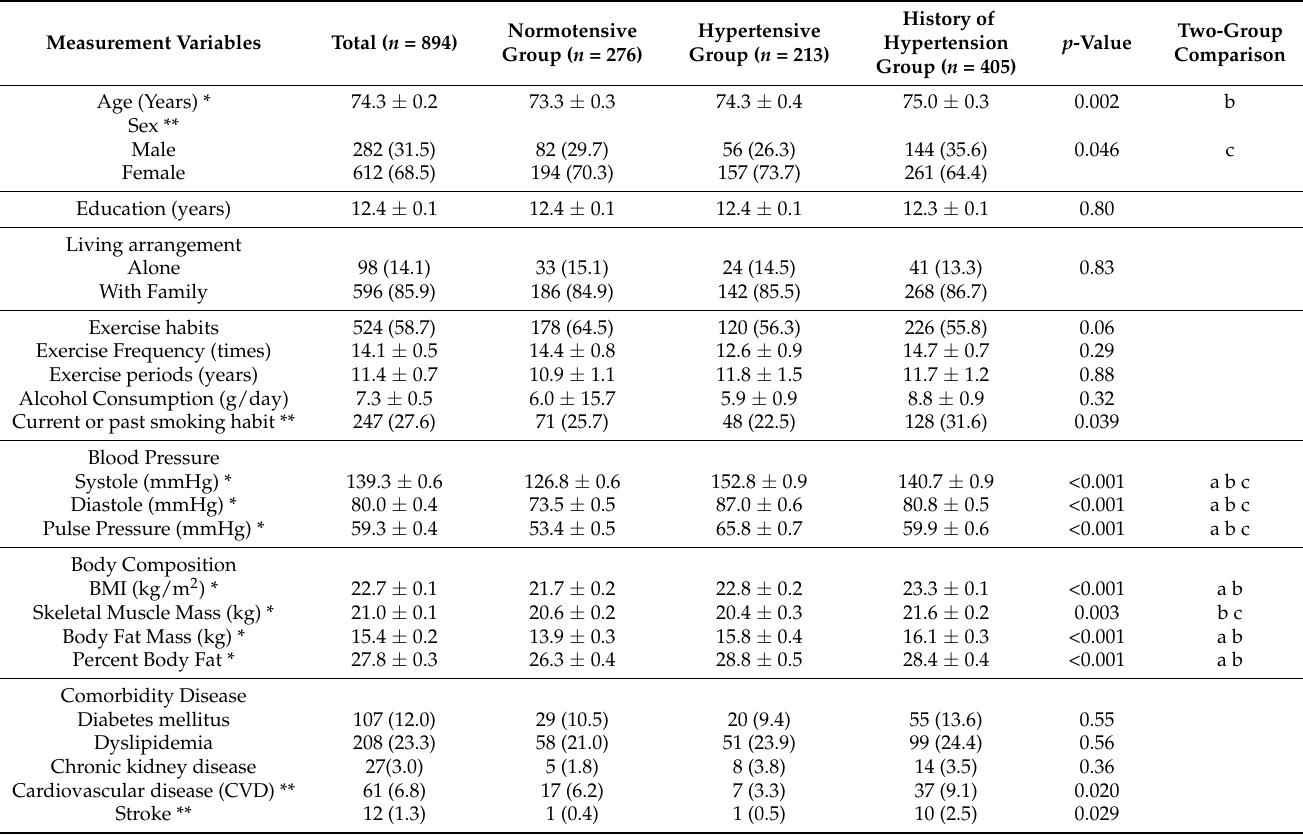
Table 1. Subject